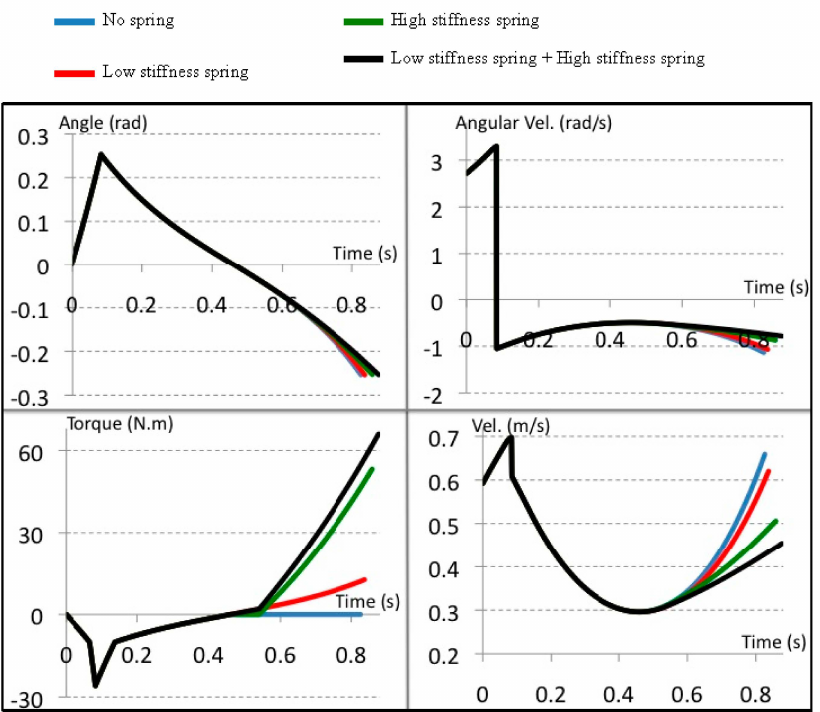
Figure 24. Simulation data for one-step walking in passive mode for 4 experimental mechanism sets. Low stiffness spring constant = 80 N/mm. High stiffness spring constant = 400 N/mm. ( a ) ankle pitch joint angle; ( b ) ankle pitch joint angular velocity; ( c ) ankle pitch joint torque; ( d ) CoM forward